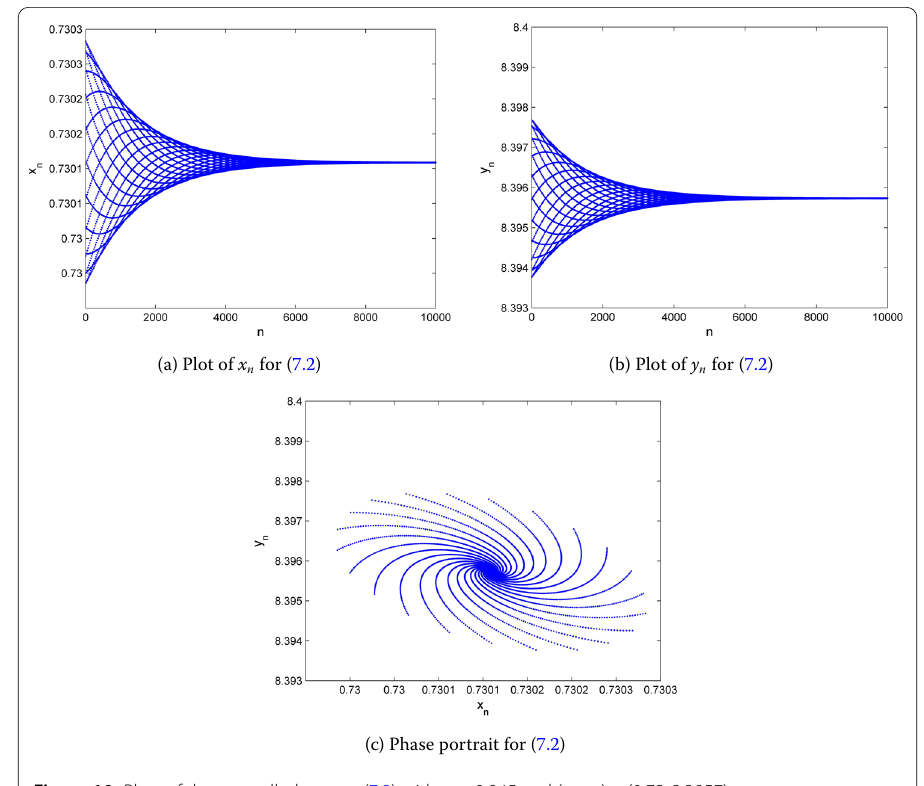
Figure 10 Plots of the controlled system (7.2) with α = 0.945 and ( x 0 , y 0 ) = (0.73,8.3957)